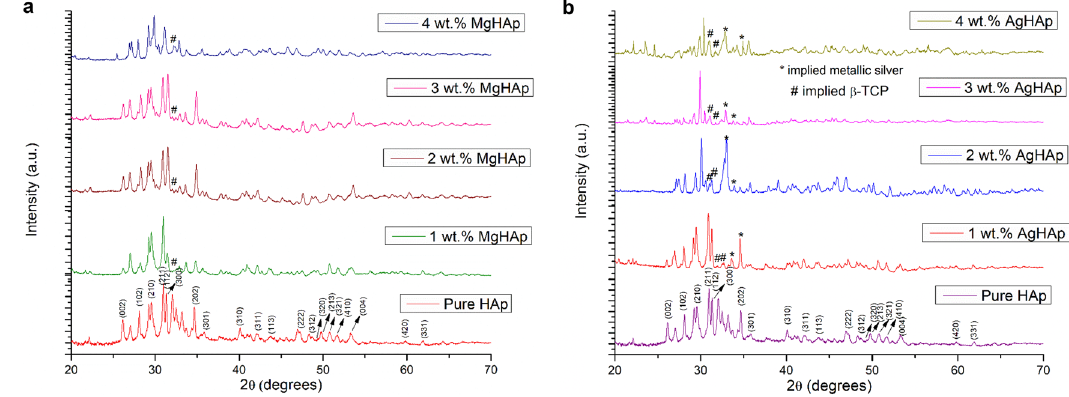
Fig. 1 a Represents the XRD graph of MgHAp samples. b Represents the XRD pattern for AgHAp